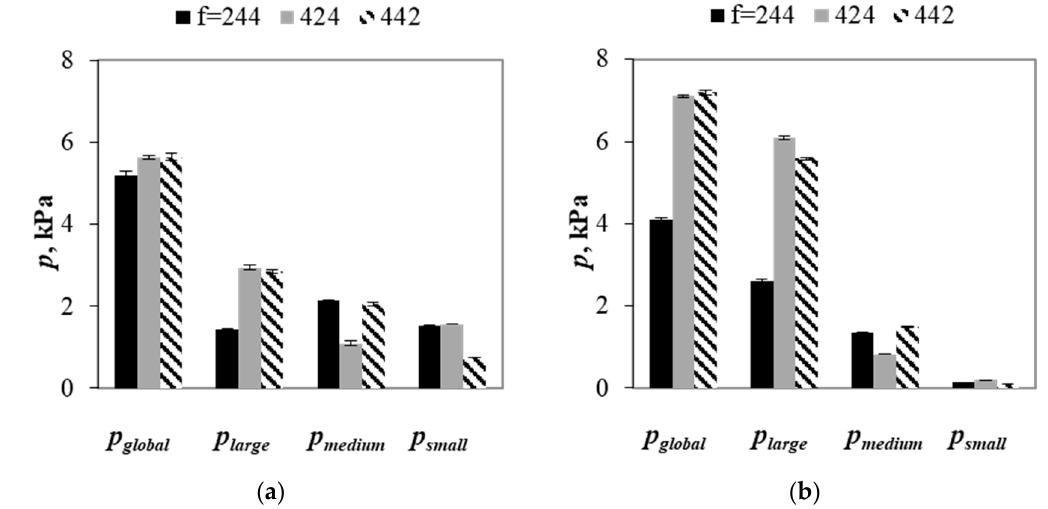
Figure 14. Global and partial stresses in mixtures with g =1.25 ( a ) and g =3.75 ( b ) and various values of f , under vertical load of 100 kPa.